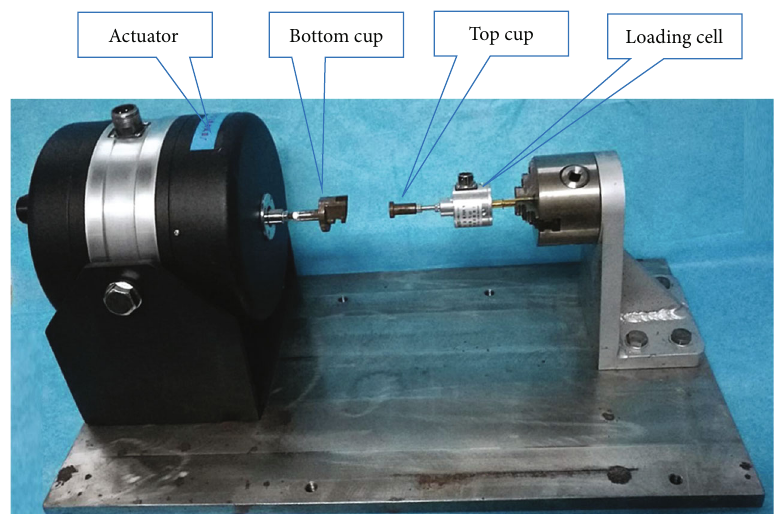
Figure 2: Custom-made dynamic loading device.